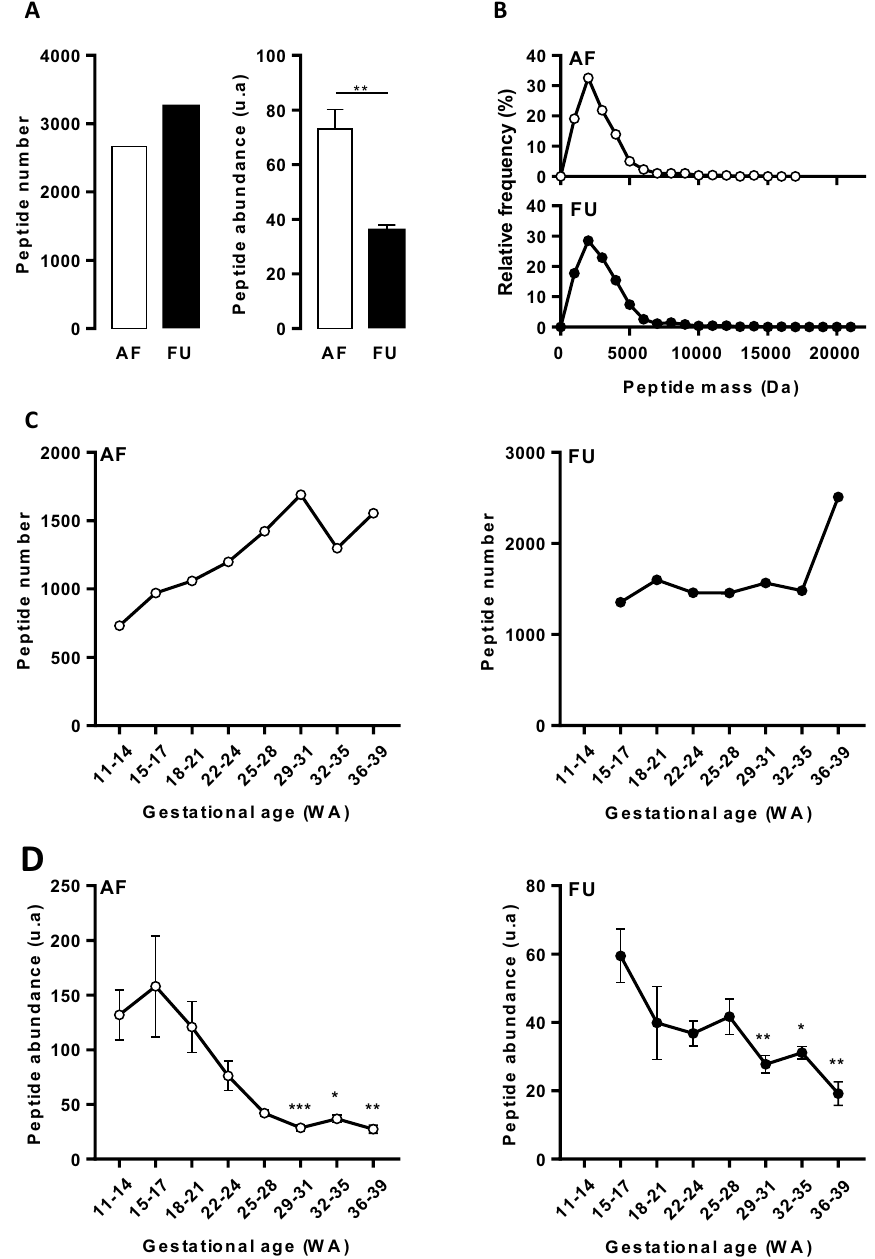
Figure 1. Amniotic fluid and fetal urine peptidome and evolution with gestational age. ( A ) Number and abundance of peptides in amniotic fluid (AF) and fetal urine (FU) irrespective of gestational age. ( B ) Weight distribution of peptides present in AF and FU. The mean and the median were respectively 2945 Da and 2425 Da for AF peptidome and 3110 Da and 2647 Da for FU peptidome. ( C ) Gestational age evolution of peptide number in AF (left panel) and FU (right panel). ( D ) Gestational age evolution of peptide abundance in AF (left panel) and FU (right panel). Data are means ± SEM. *p < 0.05, **p < 0.01, ***p < 0.001 versus 11–14 WA (AF) or 15–17 WA (FU), according to Mann–Whitney test (A) or One-way Anova